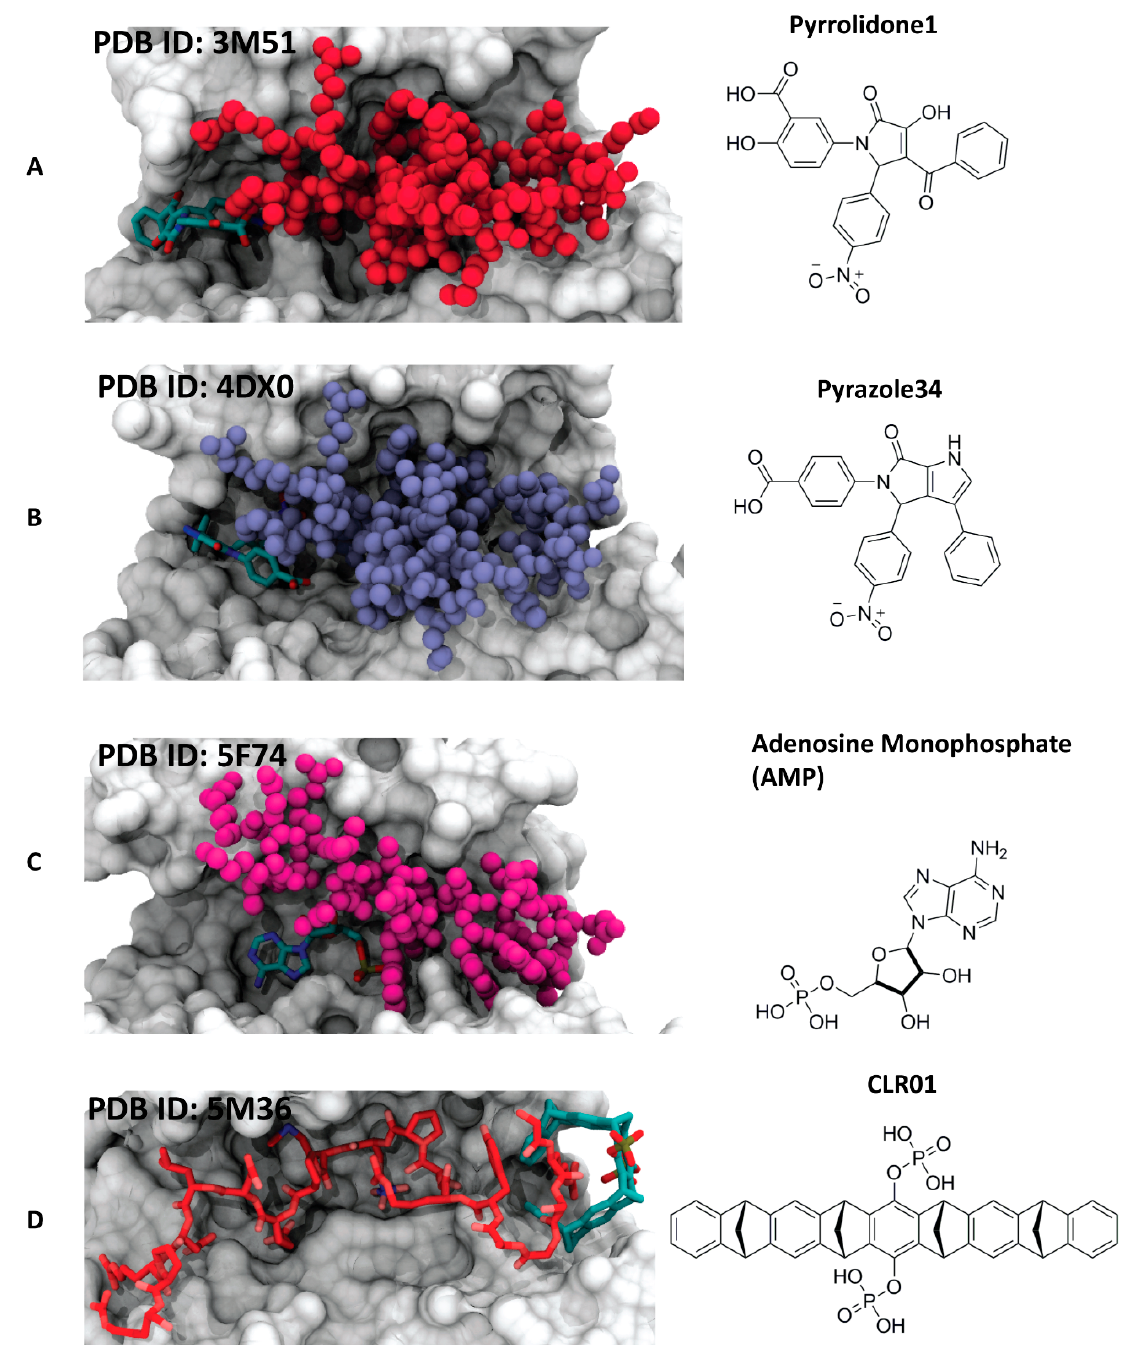
Figure 6. Examples of different synthetic 14-3-3 PPI stabilizers. ( A ) Left side: crystal structure of TASK-3 (white surface) in complex with plasma membrane H + -ATPase (PMA2) peptide (red spheres) and stabilizer pyrrolidone1 (cyan sticks) [47]; right side: chemical structure of pyrrolidone1; ( B ) left side: crystal structure of 14-3-3-like protein E (isoform of Nicotiana tabacum ) (white surface) in complex with PMA2 peptide (ice blue spheres) and stabilizer pyrazole 34 (cyan sticks) [48]; right side: chemical structure of pyrazole 34; ( C ) left side: crystal structure of 14-3-3 β (white surface) in complex with carbohydrate-response element-binding protein (ChREBP) peptide (purple spheres) and stabilizer AMP (cyan sticks) [49]; right side: chemical structure of AMP; ( D ) left side: crystal structure of 14-3-3 ζ (white surface) in complex with Cdc25C peptide (red sticks) and CLR01 (cyan sticks) [51]; right side: chemical structure of CLR01.